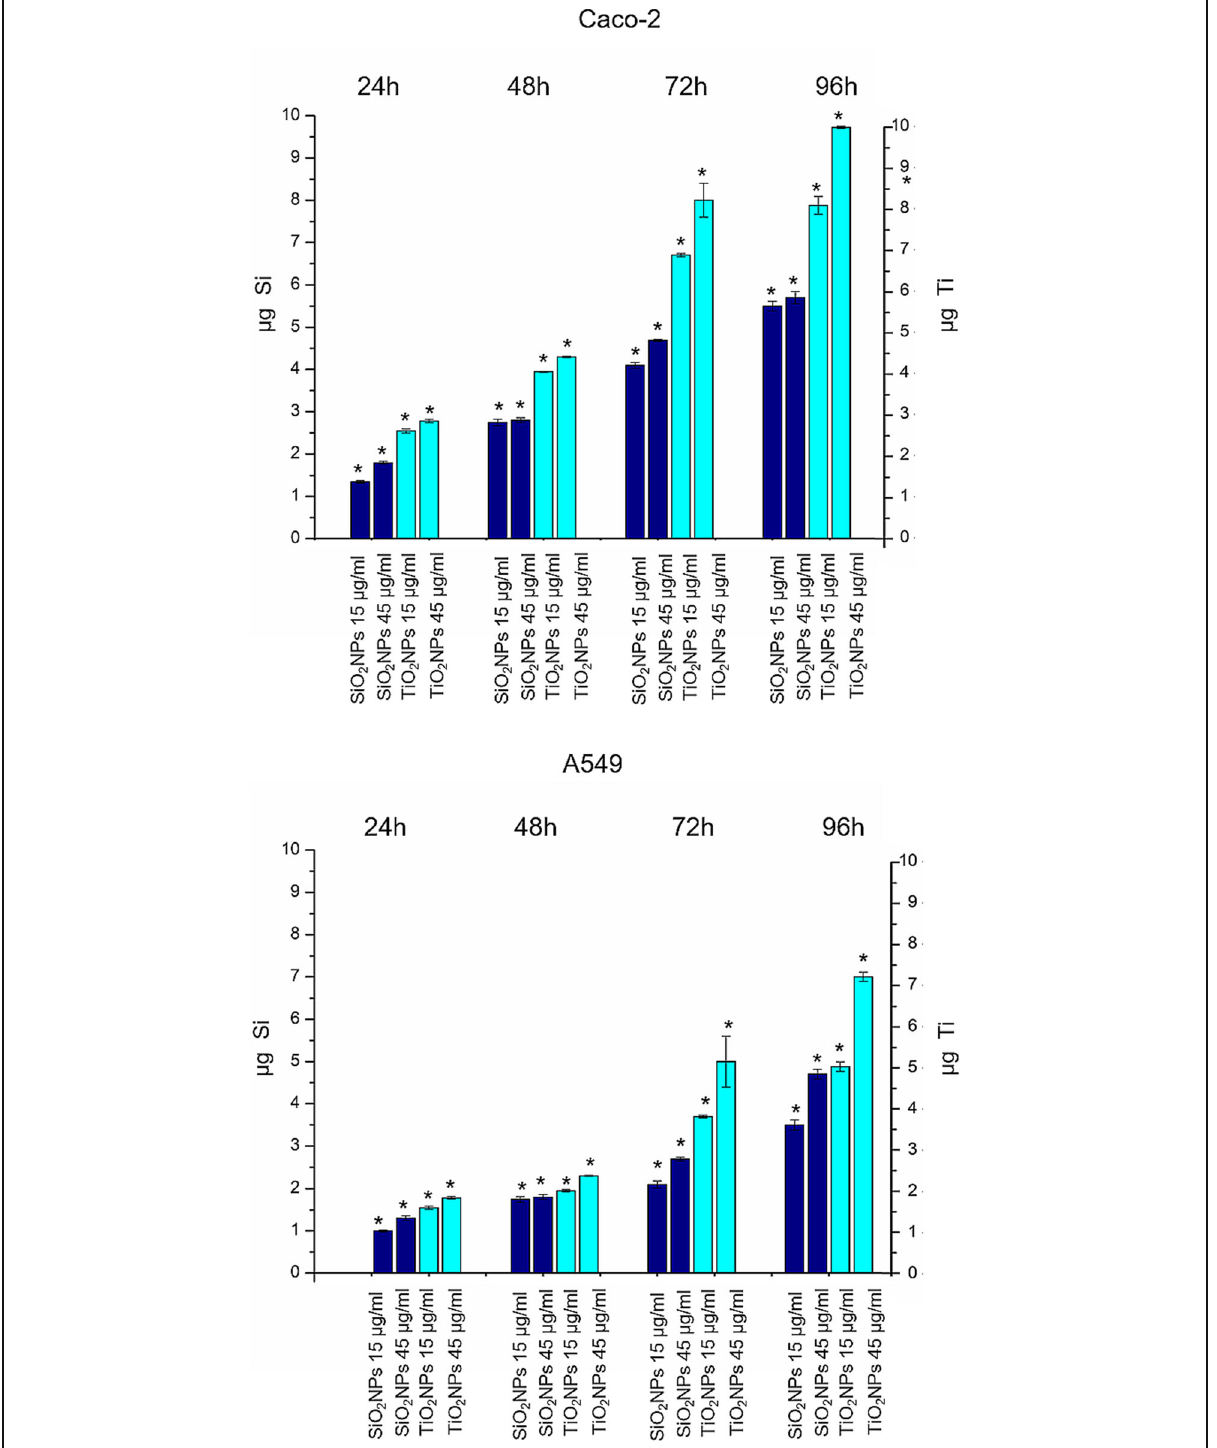
Fig. 2 TiO 2 NPs and SiO 2 NPs accumulation in Caco-2 and A549 cell lines exposed to 15 μ g/ml and 45 μ g/ml of TiO 2 NPs and SiO 2 NPs for 24 h, 48 h, 72 h, and 96 h. Cells were then harvested, live cells were counted, and Ti and Si content was measured in 360,000 cells ( μ g Ti and μ g Si). Data reported as mean ± SD from three independent experiments; statistical significance of exposed cells vs. control cells for p value < 0.05 (< 0.05*, < 0.01**, and <